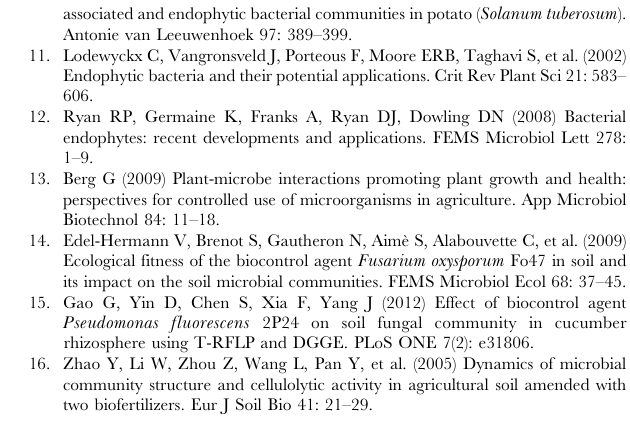
Figure S2 Non-metric multidimensional (NMDS) analysis of the effects of inoculation with Verticillium dahliae on community structure of fungi colonising the rhizosphere of four different strawberry cultivars, Honeoye, Florence, Senga Sengana and Zeph- yr, grown in three different soils. (TIF) Figure S3 Sample based rarefaction curves of all fungal operational taxonomic units (OTUs) in rhizosphere soil and roots of strawberry using Analytic Rarefaction (Ver 1.3, UGA Stratigraphy Lab, USA). (TIF) Figure S4 Fresh berry weight (g/pot) of four different strawberry cultivars, Honeoye, Florence, Senga Sengana and Zephyr, grown in conventionally and organically managed soils or a peat-based growth substrate, with and without Verticillium dahliae . Asterisks indicate statisti- cally significant differences ( p , 0.05) between control and Verticillium dahliae inoculated treatments within each soil. Vertical bars represent mean values and error bars indicate 6 1SE (n= 6). (TIF) Table S1 Similarity percentage (SIMPER) analysis of all fungal operational taxonomic units (OTUs) in rhizo- sphere and roots of four different strawberry cultivars, Honeoye, Florence, Senga Sengana and Zephyr, grown in conventionally and organically managed soils or a peat-based growth substrate, with and without Verticil- lium dahliae . All OTUs with $ 95% identity are included. (ND= not